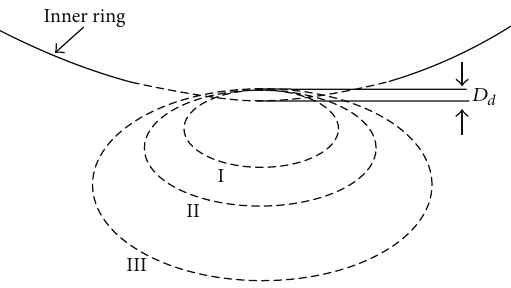
Figure 12: Inner ring: elliptical defect